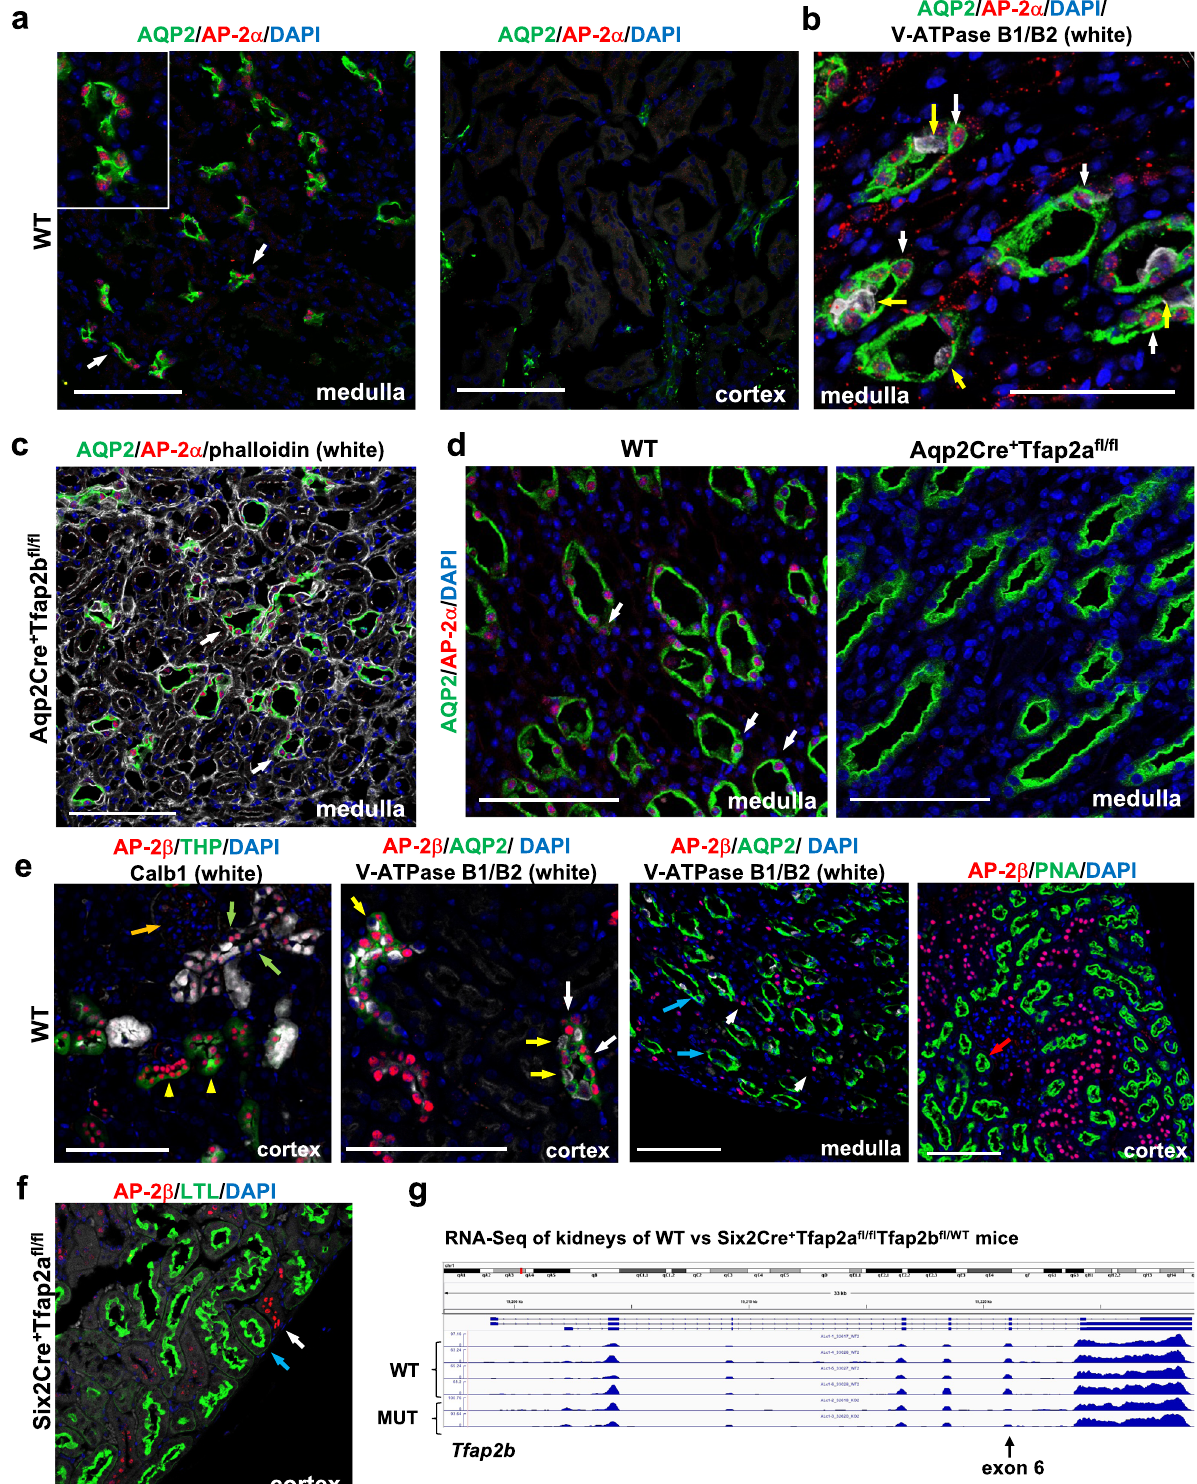
CTs/CDs (Aqp2Cre + Tfap2b fl / fl mice) show the same immunolo- calization of AP-2 α in medullary CDs as in WT mice, demon- strating that AP-2 β is not required for AP-2 α expression in medullary CDs (Fig. 1c; Supplementary Fig. S3a – c). Immunola- beling for AP-2 α in kidneys of Aqp2Cre + Tfap2a fl / fl mice shows complete loss of AP-2 α protein in inner medullary CDs, validating the speci fi city of the antibody and the ef fi cient inactivation of